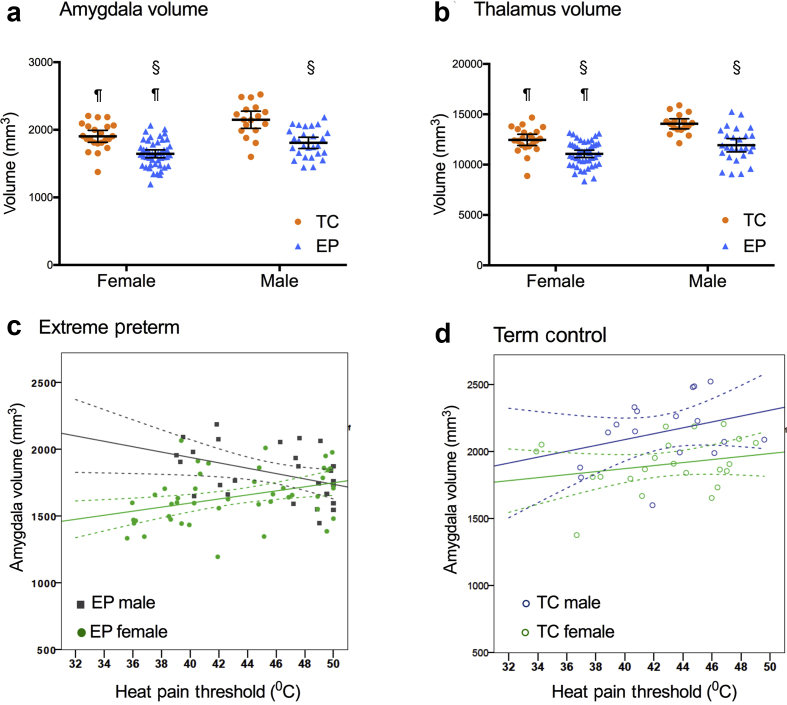
Amygdala volume and thermal sensitivity. (a,b) Volume of the amygdala (a) and thalamus (b) is influenced by EP status and sex. Scatter plot and mean (95%CI) §P<0.01 EP < TC; ¶P<0.01 female < male. (c) In EP participants, higher heat pain threshold is negatively correlated with amygdala volume in males (R2=0.17, P=0.038) and positively correlated in EP females (R2=0.14, P=0.009). (f) There is no significant relationship or sex difference in TC. Scatter plot, regression line (95%CI; See Supplementary Fig. 2 for amgdalothalamic tract fractional anisotropy and average intra-axonal volume fraction).